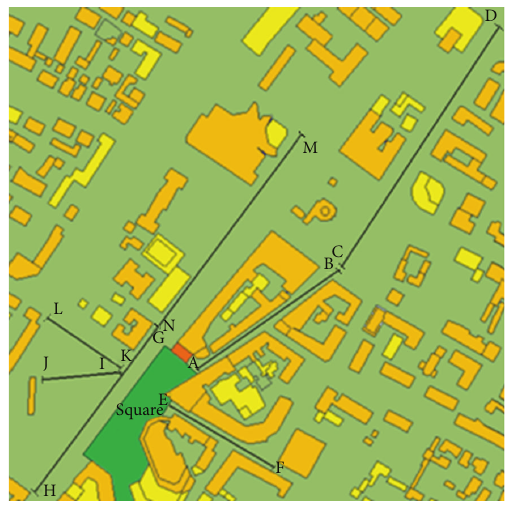
Figure 1: Observed surface and routes in the city centre.